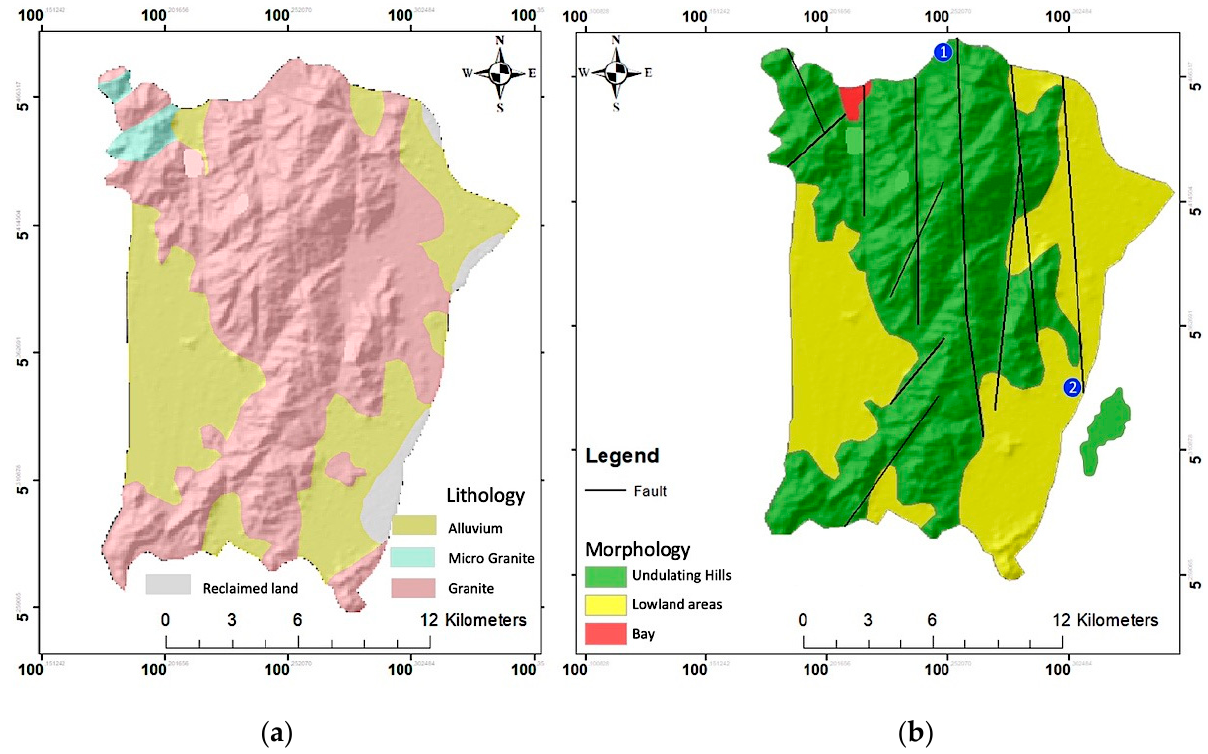
Figure 11. Comparison between ( a ) lithology map (modified from [40]) and ( b ) geomorphology map of the overall Penang Island. Both sites are beach landforms. Symbol 1 and 2 represent the survey site 1 and survey site 2.